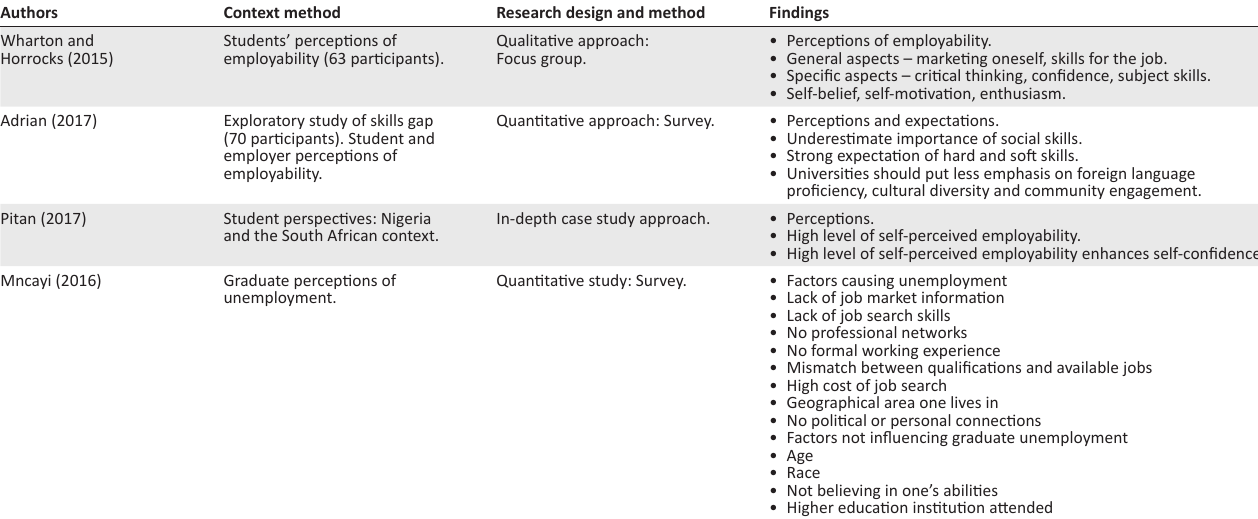
TABLE 1: Summary of findings of factors influencing student employability.